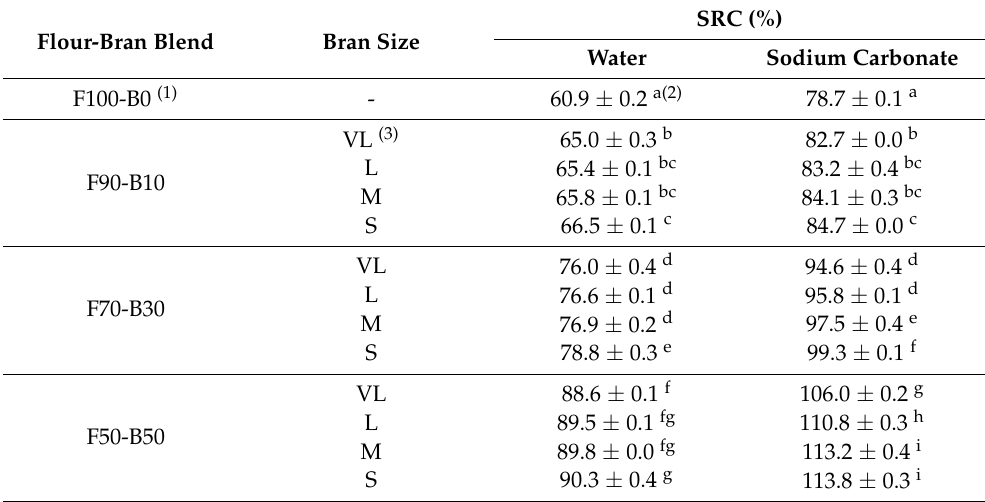
Table 3. Moisture content and solvent retention capacity values of flour-bran blends with different bran sizes and blend